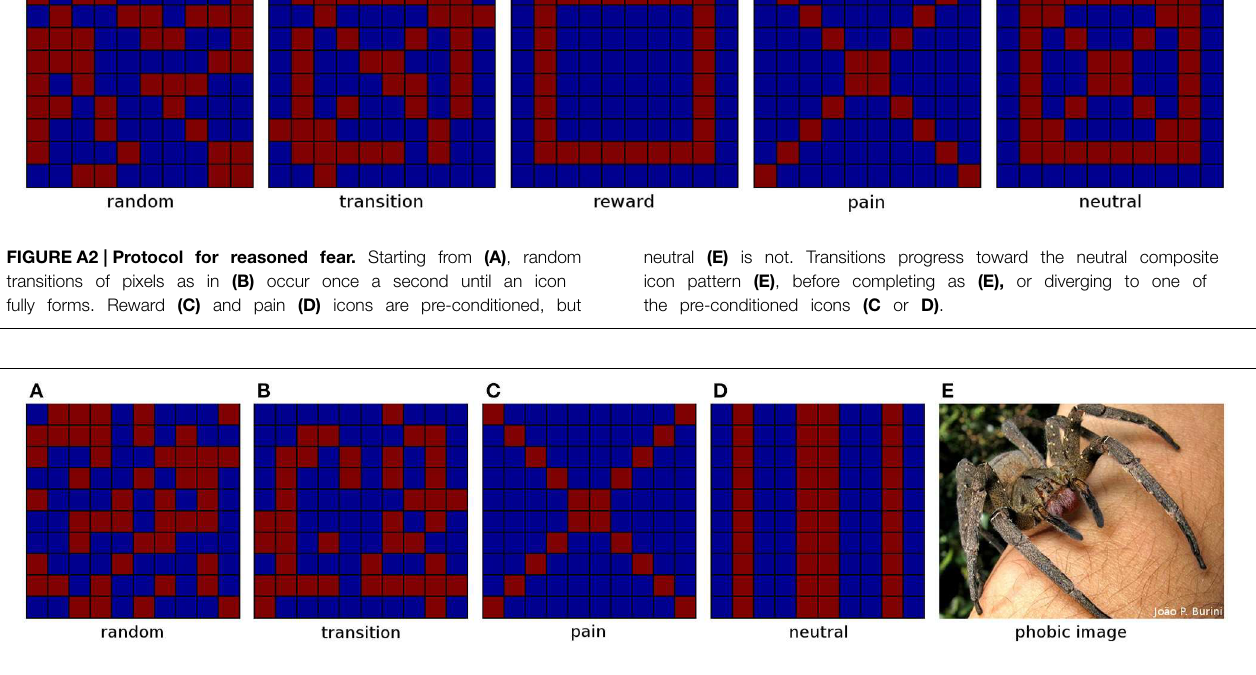
neutral icons or phobic images are not. Transitions progress toward the painful or neutral icon patterns and complete while delivering any painful stimulus